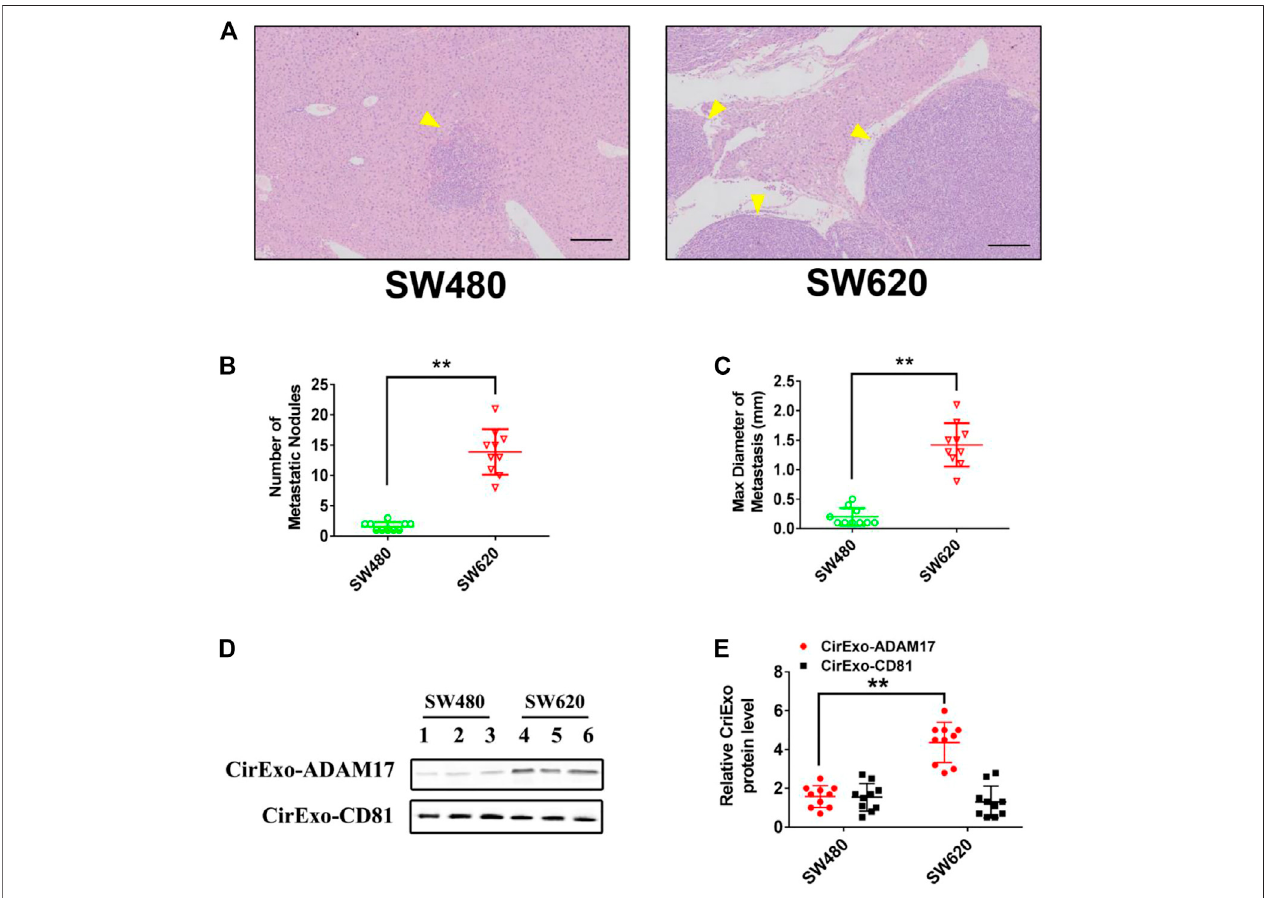
FIGURE 4 | Exosomes derived from CRC cells promote liver metastasis. SW480 and SW620 cells were implanted into the mesentery at the tail end of the cecum. Autopsies were performed, and the presence ofmetastases was examined macroscopically 60 days after CRC implantation. (A) Representative H&E staining results of liver slices from SW480- and SW620-implanted mice. Arrows indicate the tumor nodules. Scale bar, 250 μ m. (B,C) The number and maximal diameter of metastatic nodules in the livers of SW480- and SW620-implanted mice were calculated and analyzed ( n (cid:2) 10). (D,E) The serum-derived exosomes of SW480- and SW620- implanted mice were collected and lysed for analysis of ADAM17 and CD81 protein levels. The relative protein levels were further calculated via gray analysis (the total exosomal protein was set as the internal control, n (cid:2) 10). Data are expressed as means ± SDs. *, p < 0.05; **, p <